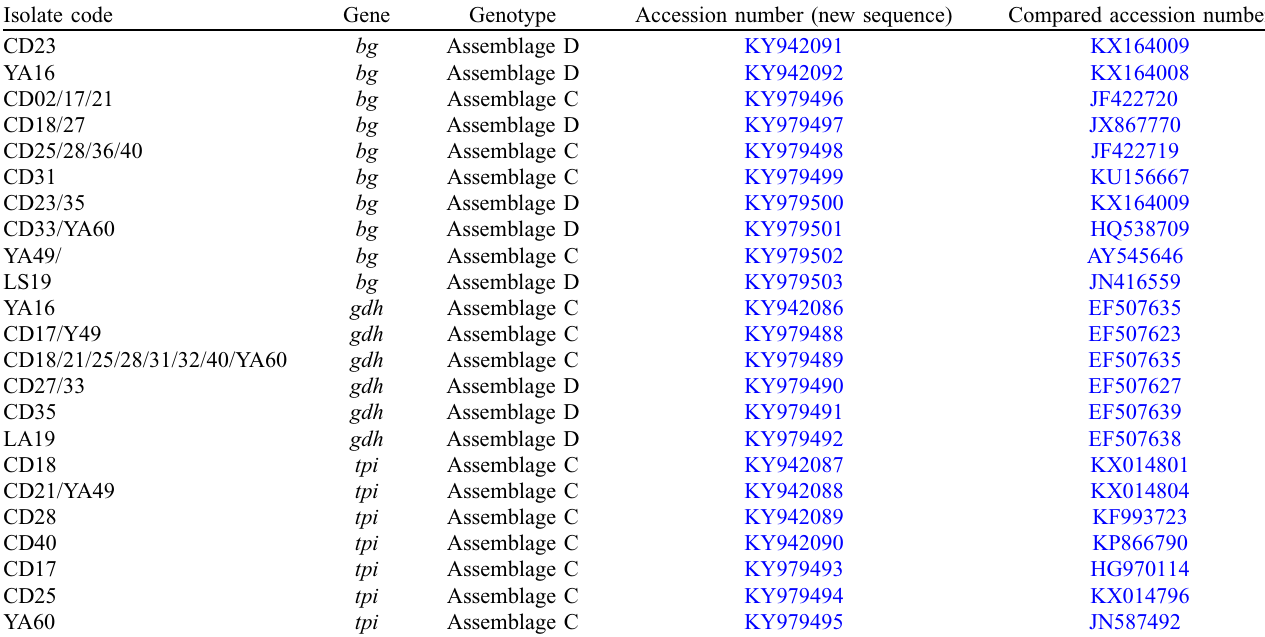
Table 3. Sequences with SNPs and corresponding accession numbers. Isolate code